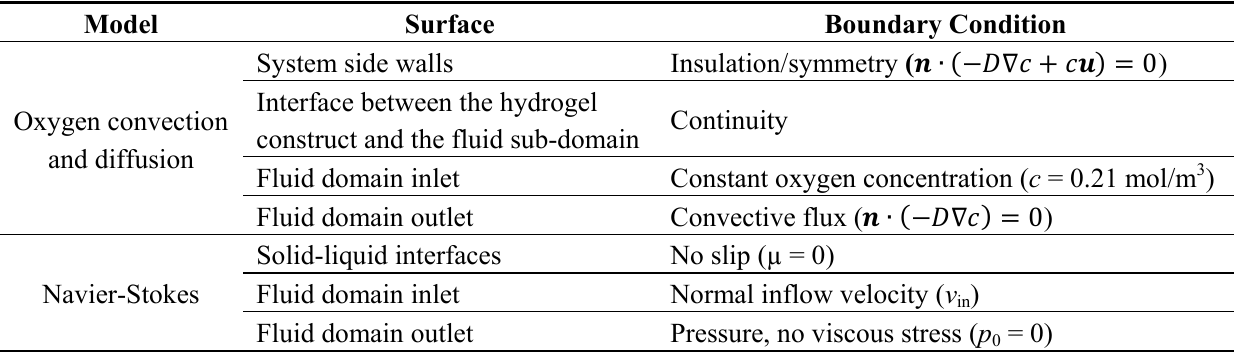
Table 4. Boundary conditions used for the oxygen convection and diffusion and for the Navier-Stokes